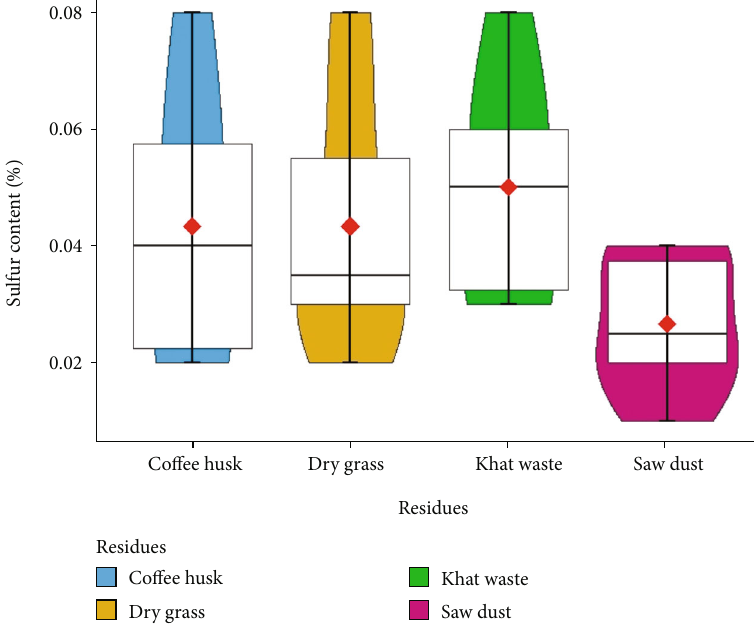
Figure 6: E ff ect of residues on percentage of sulfur content of the briquette. Table 2: Mean ignition time of the biomass waste briquettes.